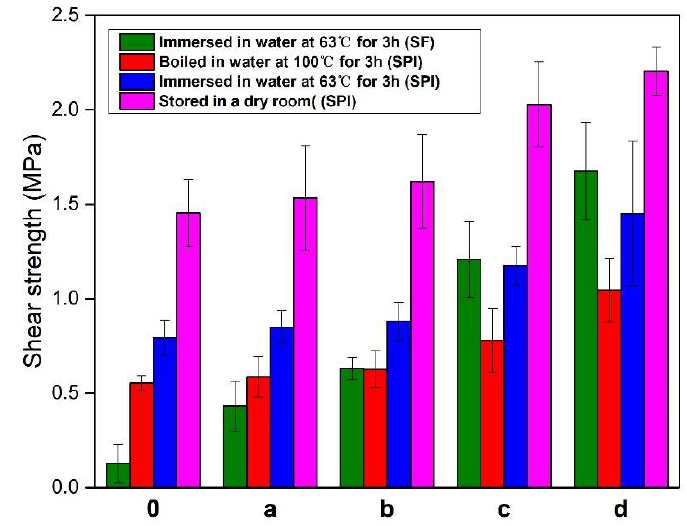
Figure 5. Shear strengths of SF and SPI adhesives: 0 (SF and SPI adhesives); a (SF/3% HMP and SPI/3% HMP adhesives); b (SF/6% HMP and SPI/6% HMP adhesives); c (SF/9% HMP and SPI/9%